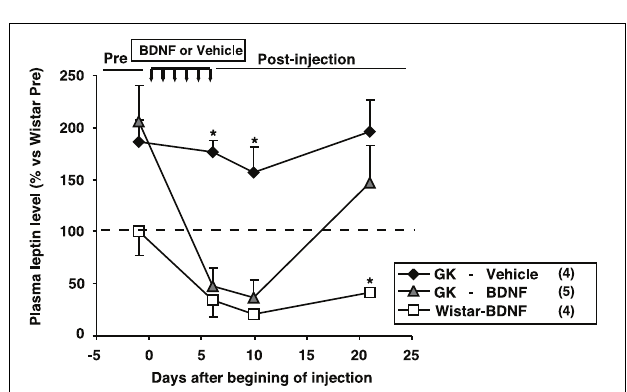
FIGURE 4 | Effect of icv BDNF treatment daily for 6 days on plasma leptin levels in GK rats. Plasma leptin levels at 0, 6th, 10th, 21st days after beginning of BDNF or vehicle injections. BDNF treatment significantly reduced plasma leptin level in GK rats. ∗ p < 0 . 05 vs. other groups (One-Way ANOVA with Holm’s post-hoc